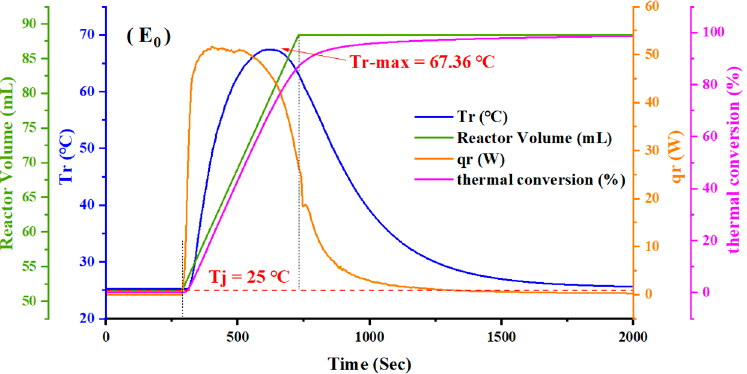
Figure 10. Experimental results of the control experiment without the microPCMs.